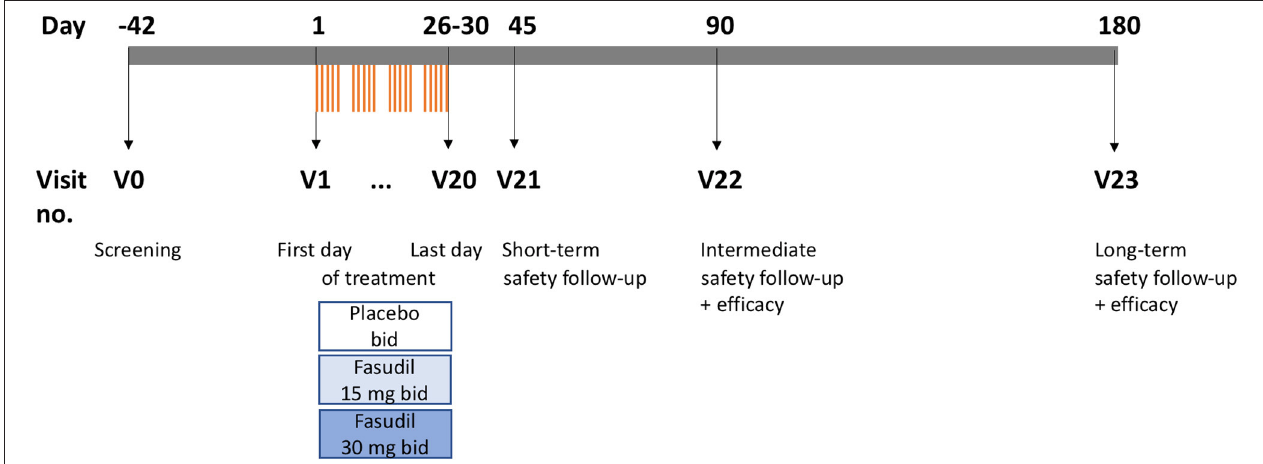
FIGURE 1 | Scheme of trial (drawn to time scale). V, visit; bid, two times daily.